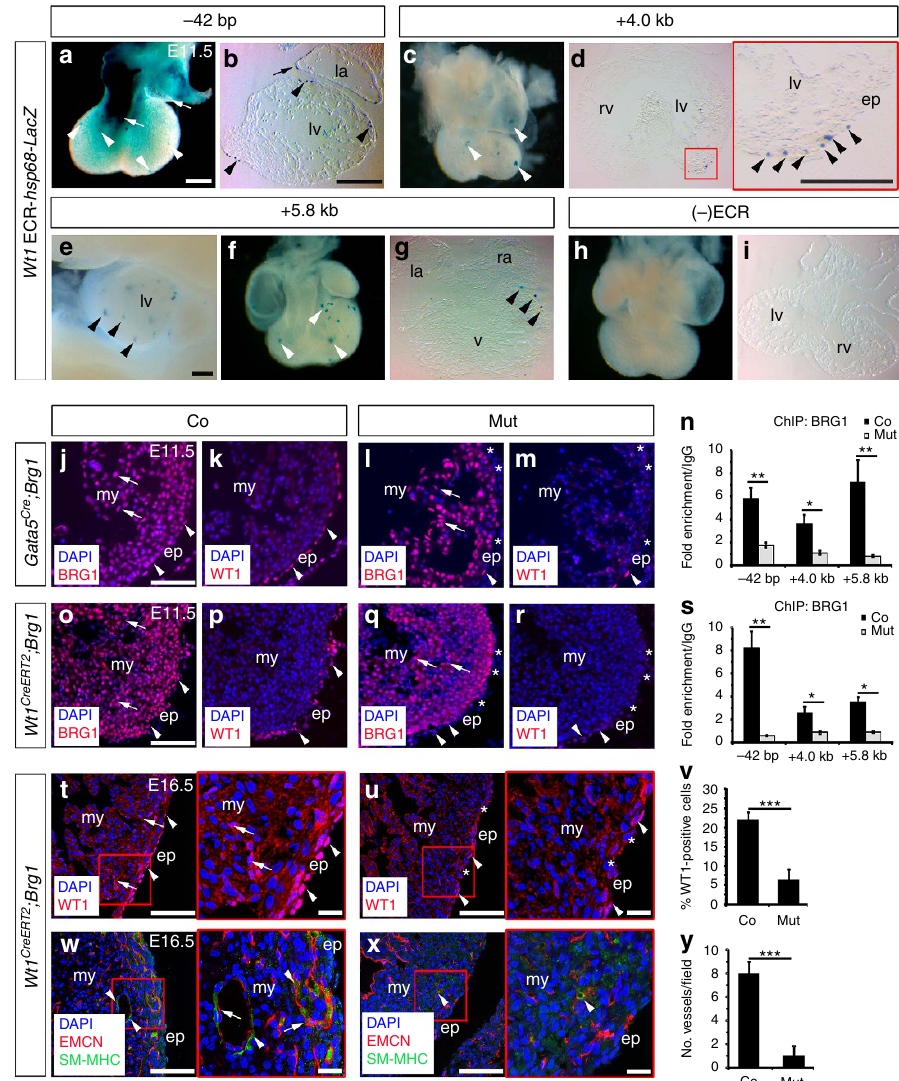
Figure 3 | Wt1 ECRs drive gene expression and BRG1 is required for EPDC activity. ( a – i ) Wt1 ECRs are sufficient to drive LacZ expression in the epicardium at E11.5. Whole-mount ( a , c , e , f , h ) and transverse-sectioned hearts ( b , d , g , i ) are shown. Arrowheads mark epicardium covering the ventricles; arrows mark epicardium covering the atria ( a , b ) and outflow tract ( a ). Two ( (cid:2) 42bp), five ( þ 4.0kb) and six ( þ 5.8kb) transgenic mice were examined to assess the reproducibility of reporter activity patterns. ( j – s ) BRG1 and Wt1 immunostaining of E11.5 hearts documenting Brg1 deletion (asterisks in l , q ) and Wt1 reduction (asterisks in m , r ) in the epicardium of Brg1 cKOs compared to littermate controls (arrowheads in j , k and o , p ). Note reduced BRG1 expression also in the myocardium (arrows; compared j with l versus o with q ) of Gata5 Cre ;Brg1 flox/flox , but not Wt1 CreERT2 ;Brg1 flox/flox hearts. ( n , s ) BRG1 ChIP-qPCR data. Three independent ChIP experiments were performed per group ( n ¼ 10 hearts) and are presented as fold enrichment over IgG. ( t , u ) Wt1 immunostaining of E16.5 hearts documenting fewer Wt1-positive cells in the epicardium (arrowheads) and EPDCs invading the subepicardial and myocardial layers (arrows) in Brg1 cKOs. Note magnified views of (red) inset boxes in t and u . ( v ) Quantification of Wt1-expressing cells in E16.5 hearts as % ¼ (total number of Wt1- positive cells per section/total number of DAPI nuclei per section) (cid:3) 100; co, n ¼ 3 hearts; mut, n ¼ 4 hearts. ( w , x ) Endomucin (EMCN) and smooth- muscle myosin heavy chain 11 (SM-MHC) immunostaining of E16.5 hearts documenting a reduction of patent coronary vessels, containing endothelium (arrow) surrounded by smooth muscle (arrowheads), in Brg1 cKOs hearts. Note magnified views of (red) inset boxes in panels w and x . ( y ) Quantification of patent vessels per field in E16.5 hearts; 6 fields analysed per section per genotype; co, n ¼ 3 hearts; mut, n ¼ 4 hearts. All error bars are data ± s.d. Significant differences ( P values) were calculated using two-tailed Student’s t -test (* P r 0.05; ** P r 0.01; *** P r 0.001). co, control; ep, epicardium; la, left atrium; lv, left ventricle; mut, mutant; my, myocardium ra, right atrium; rv, right ventricle; v, ventricle. All scale bars 200 m m, except j , o , t , u , w , x 100 m m and magnified views of inset boxes in t , u , w , x 20 m